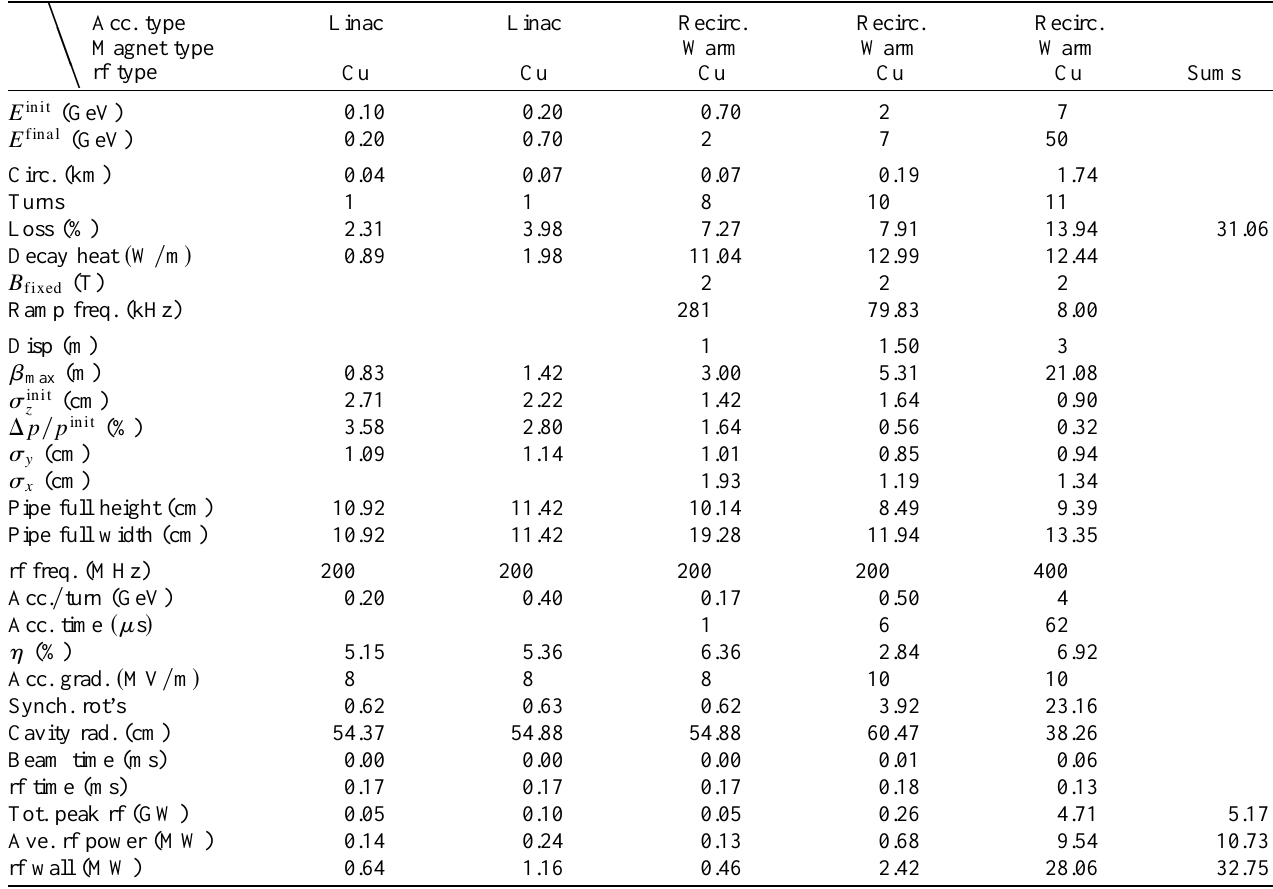
TABLE IX. Accelerator parameters for a Higgs factory (100